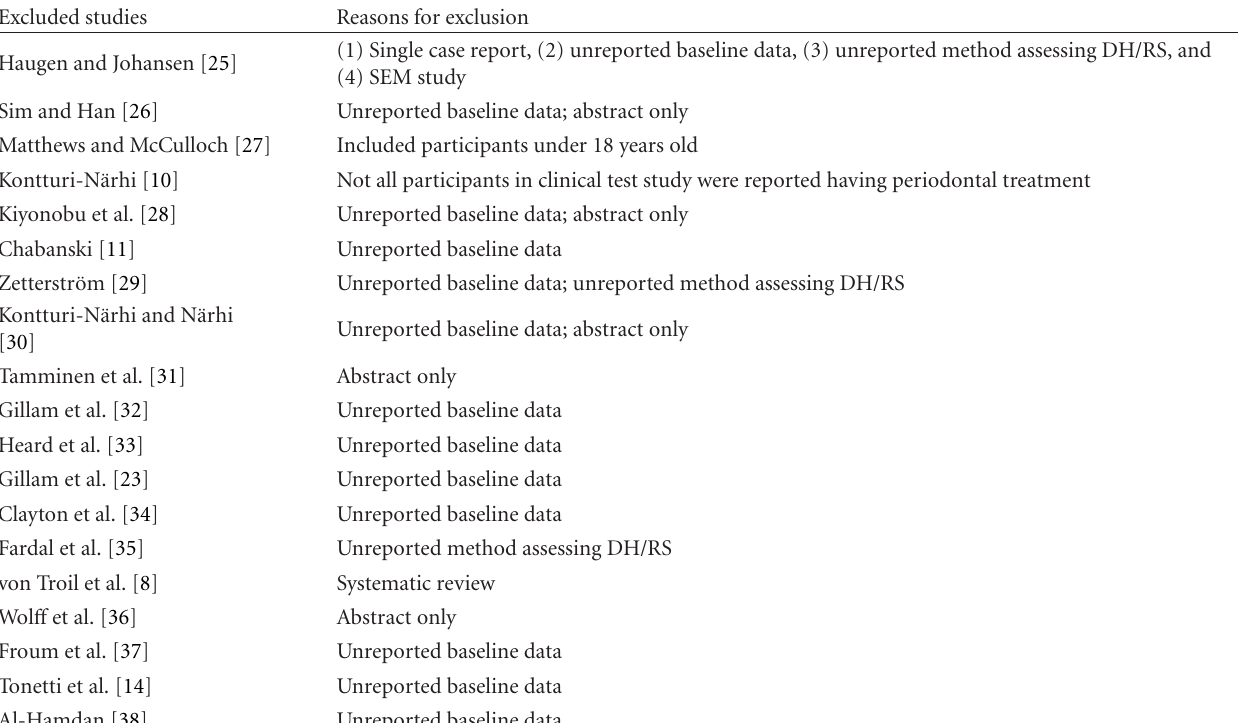
Table 1: Characteristics of excluded studies (reasons for exclusion).